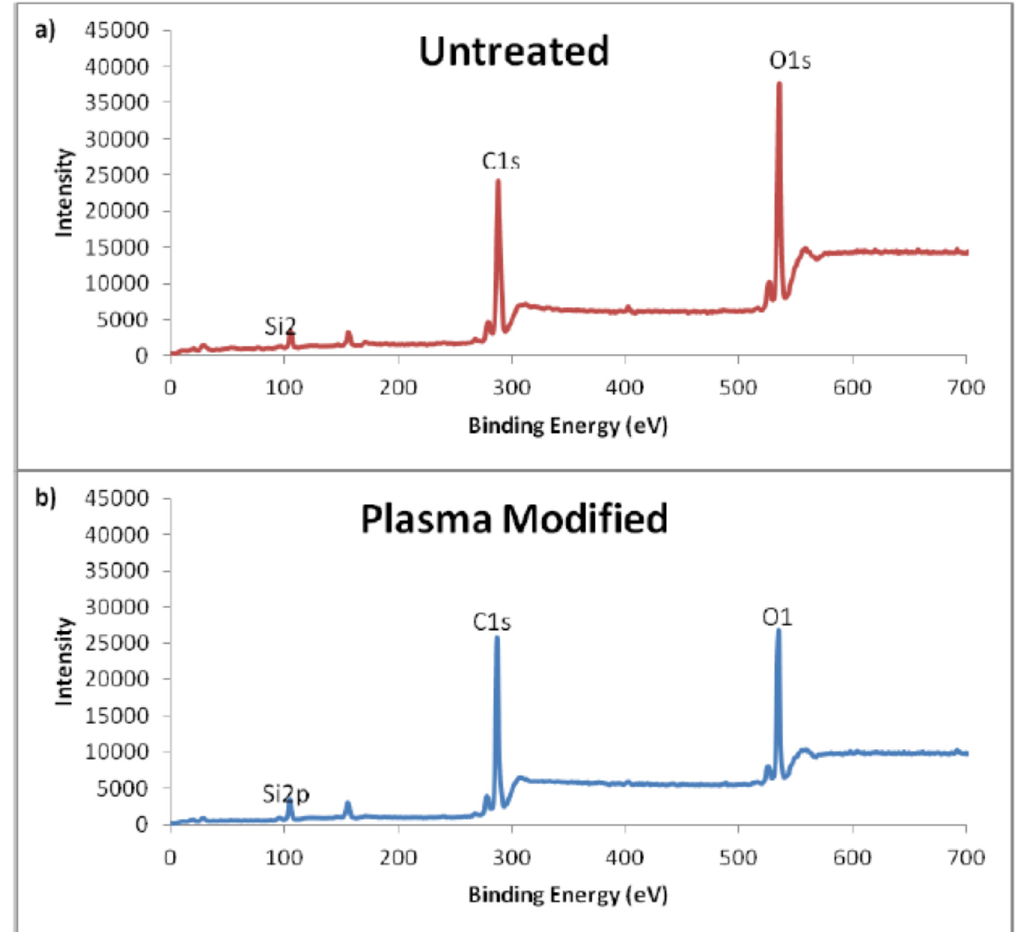
Figure 10. Surface elementary composition of ( a ) untreated and ( b ) TMS plasma-modified rayon flock synthetic leather (treatment parameters: amount of TMS = 0.2 mL; flow rate of helium = 12.5 LPM; discharge power = 50 W; jet distance = 10mm; treatment time = 30 s).